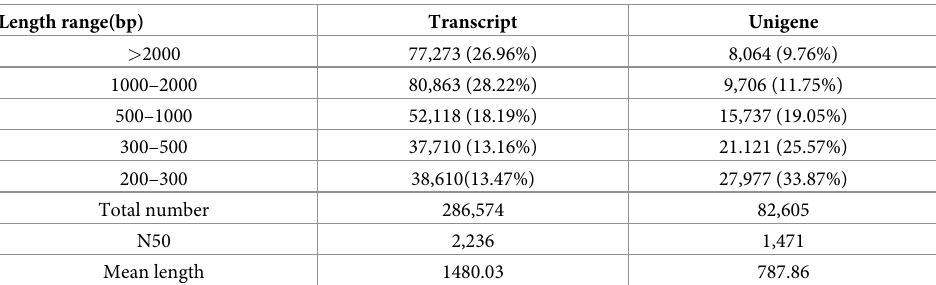
Table 2. Overview of the